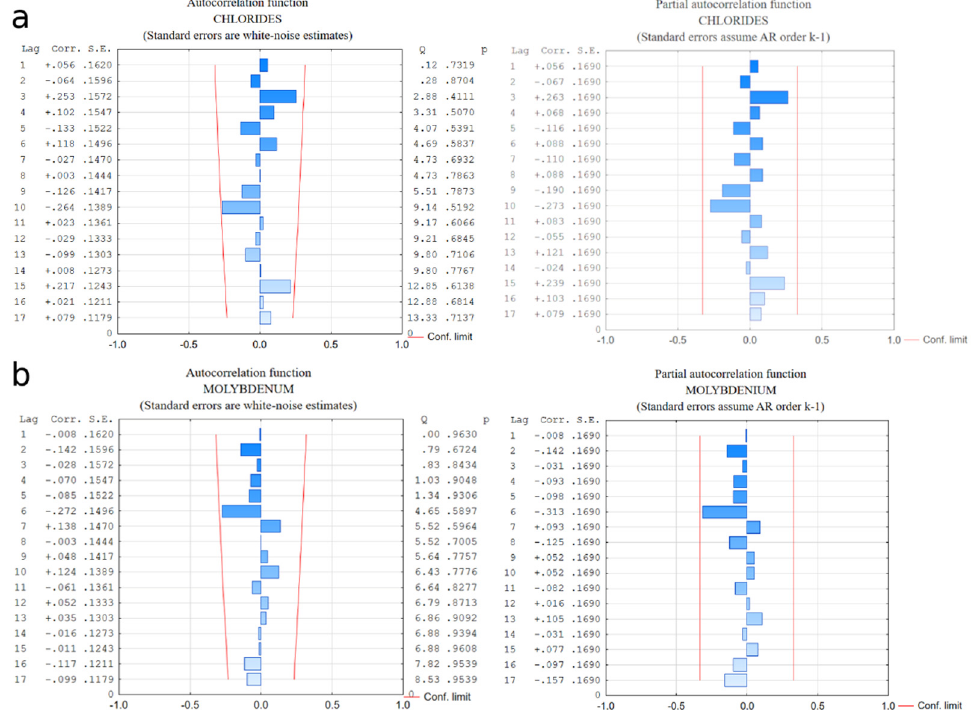
Figure 4. Analysis of seasonality (ACF and PACF; chlorides, molybdenum). Analysis of the seasonality using ACF and PACF shows the lack of trend and season- ality in copper, dry mass, lead, sulfates, and zinc. The correlation values for the individual lags are low and do not exceed the confidence levels.